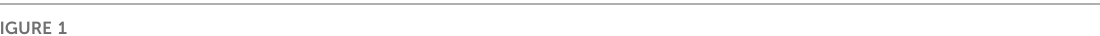
FIGURE 1 without ( D1 , top) and with white noise ( D2 , top) to generate repetitive fi ring ( D1 , bottom; D2 , bottom). Instantaneous fi ring frequencies without (D3) and with (D4) WN were calculated from corresponding fi rings (D1) and (D2) , respectively. (E) : The relationship between slopes of rising phase of the